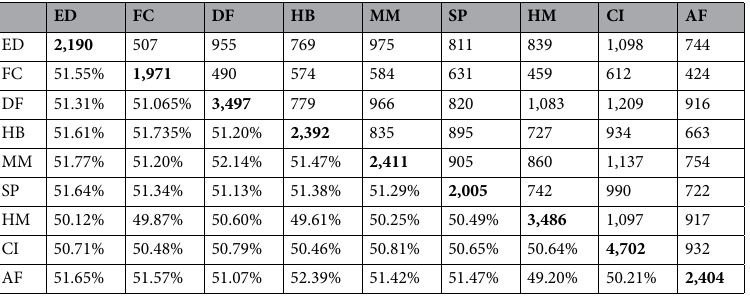
Table 2. Numbers of orthologous proteins shared between genomes (upper right) and AGIOS values (lower left). The numbers of proteins per genome are indicated in bold. ED: Eubacterium dolichum; FC: Faecalitalea cylindroides; DF: Dielma fastidiosa; HB: Holdemanella biformis; HM: Holdemania massiliensis: SP: Streptococcus pleomorphus; MM: Merdibacter massiliensis; CI: Clostridium innocuum; AF: Anaerorhabdus furcosa .